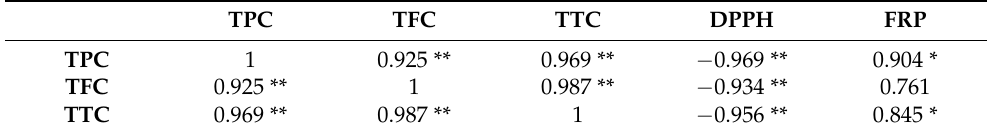
Table 6. The correlation between the phenolic compounds and antioxidant